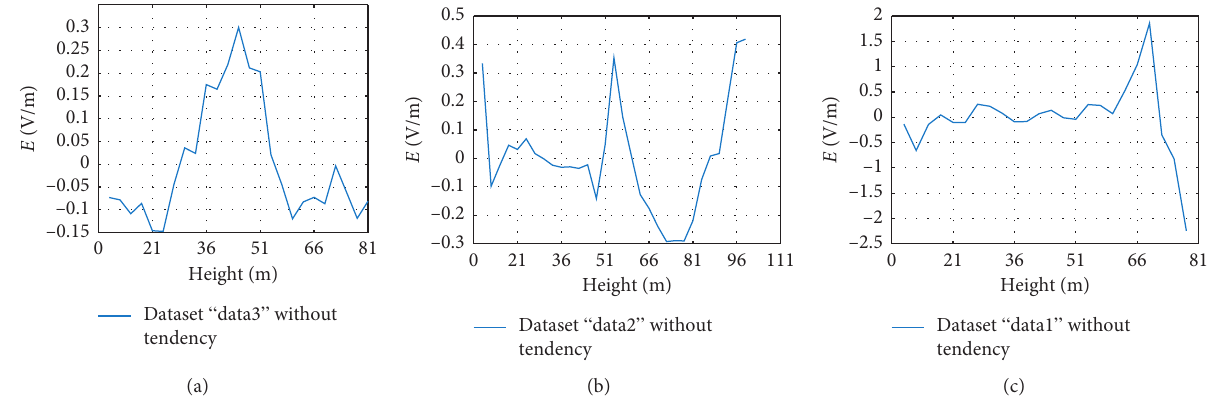
Figure 10: Graph of (a) “data3” without tendency ( Y